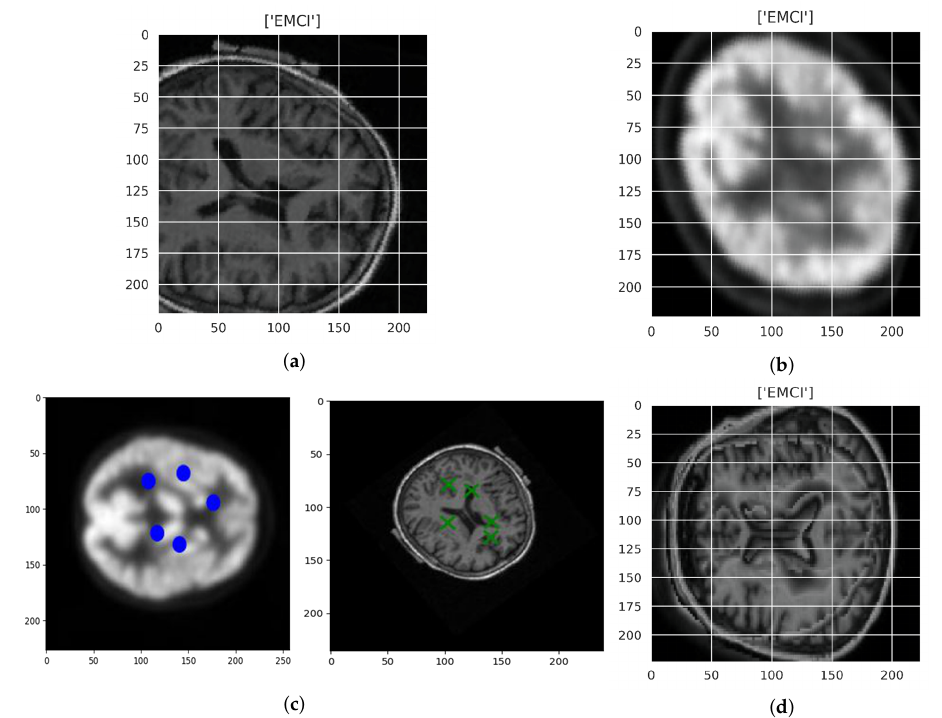
Figure 3. ( a ) Original MRI image (EMCI), ( b ) Original PET image (EMCI), ( c ) MRI and PET Image Registration Points for Alignment, ( d ) Fused Image